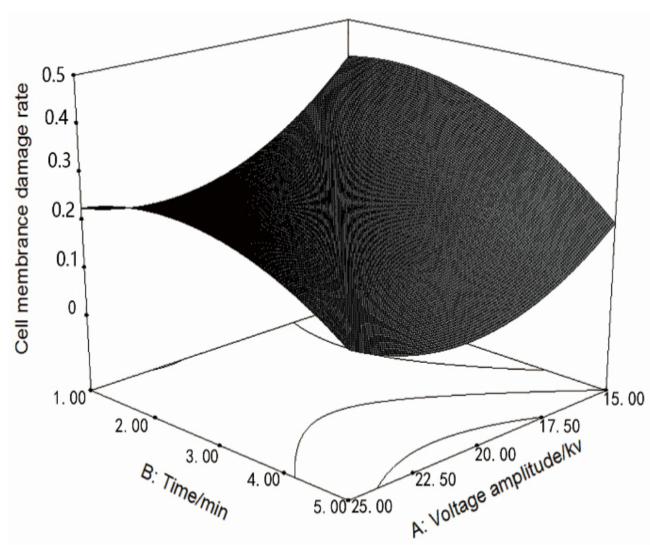
Figure 2. Response surface analysis of voltage amplitude and processing time.